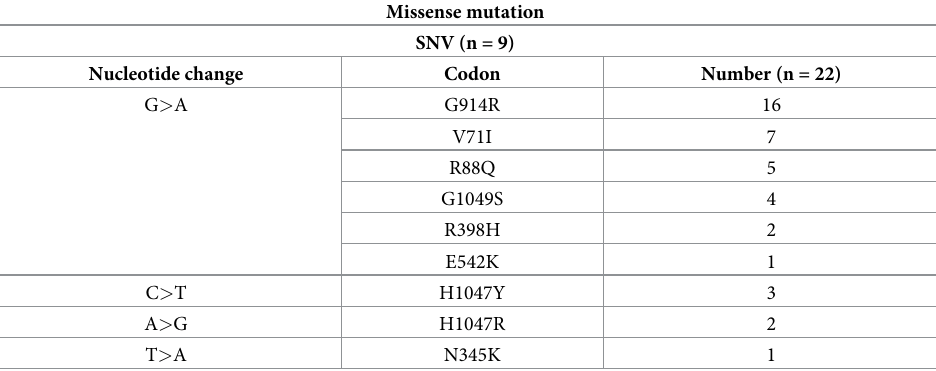
MLH1 mutation occurred in 10 of 22 (45,45%) subjects. The nonsense mutation occurred in exon 9–13, causing termination in 4 codons. The most frequently occurred SNV was Q391 � (Table 9). Biological behavior of malignancy with co-occurring mutation (Table 10) Co-occurring mutations of APC , TP53 , PIK3CA , and KRAS were identified in 8 patients with an average age of 48,5 years old, with locally-advanced stage (n = 5), located in the rectum (n = 6), well-differentiated (n = 6), and positive lymphovascular invasion (n = 5). Table 8. PIK3CA mutation.